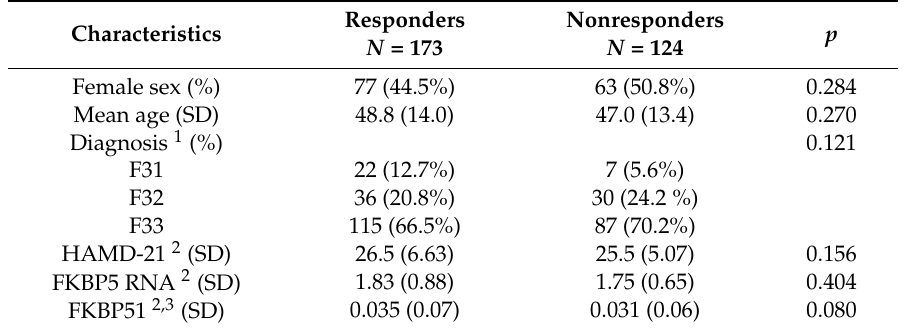
Table 1. Demographic and baseline characteristics of responders and non-responders to six weeks of antidepressant